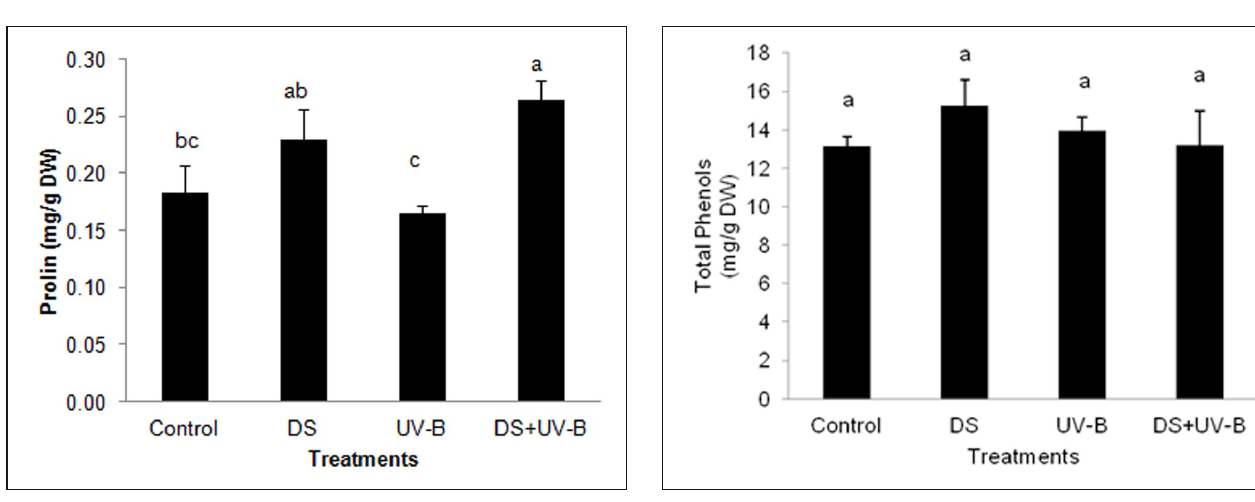
Fig. 3: Proline content (mg g -1 DM) of lettuce at harvest in response to drought stress, UV-B radiation and the combination of drought stress and UV-B radiation. Vertical bars represent standard deviation, and different letters indicate differences at the significance level p ≤ 0.05 (Tukey test). (Control = well-watered; DS = drought stress, i.e. water-deficit; UV-B = well-watered with UV-B radiation of 0.11 kJ m -2 ; DS+UV-B = drought stress i.e. water-deficit in combi- nation with UV-B).